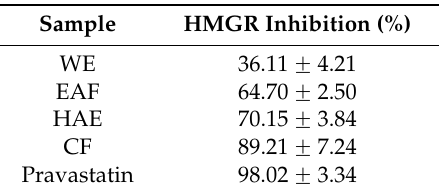
Table 3. HMGR percentage inhibition values for the extracts and fractions of A. wilhelmsii, along with the control (pravastatin). Each value represents the mean ± SD of three independent measurements.